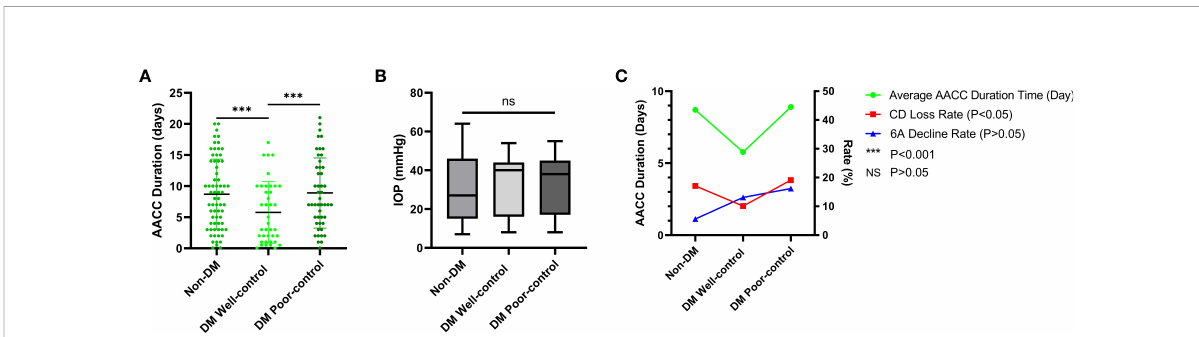
FIGURE 2 The Average Duration Time of Acute Angle Closure Crisis (AACC), Intraocular Pressure (IOP) of AACC Eyes and Correlations between the AACC Duration, Cell Density (CD) Loss Rate and Percentage of Hexagonal Cell (6A) Decline Rate. DM, diabetes mellitus. (A) The scatterplot showed the tendency of duration time of three groups, the line of each group meant the average duration. Statistically signi fi cant differences were detected between non-DM group and DM well-control group (P < 0.001), DM well-control group and DM poor-control group (P < 0.001). (B) The boxes showed the average IOP of 10-90 percentile, the line in box meant the median of IOP. Both the differences of average IOP and median of IOP were not statistically signi fi cant among three groups. (C) Line chat showed average AACC duration was correlated with CD loss rate, but not with 6A decline